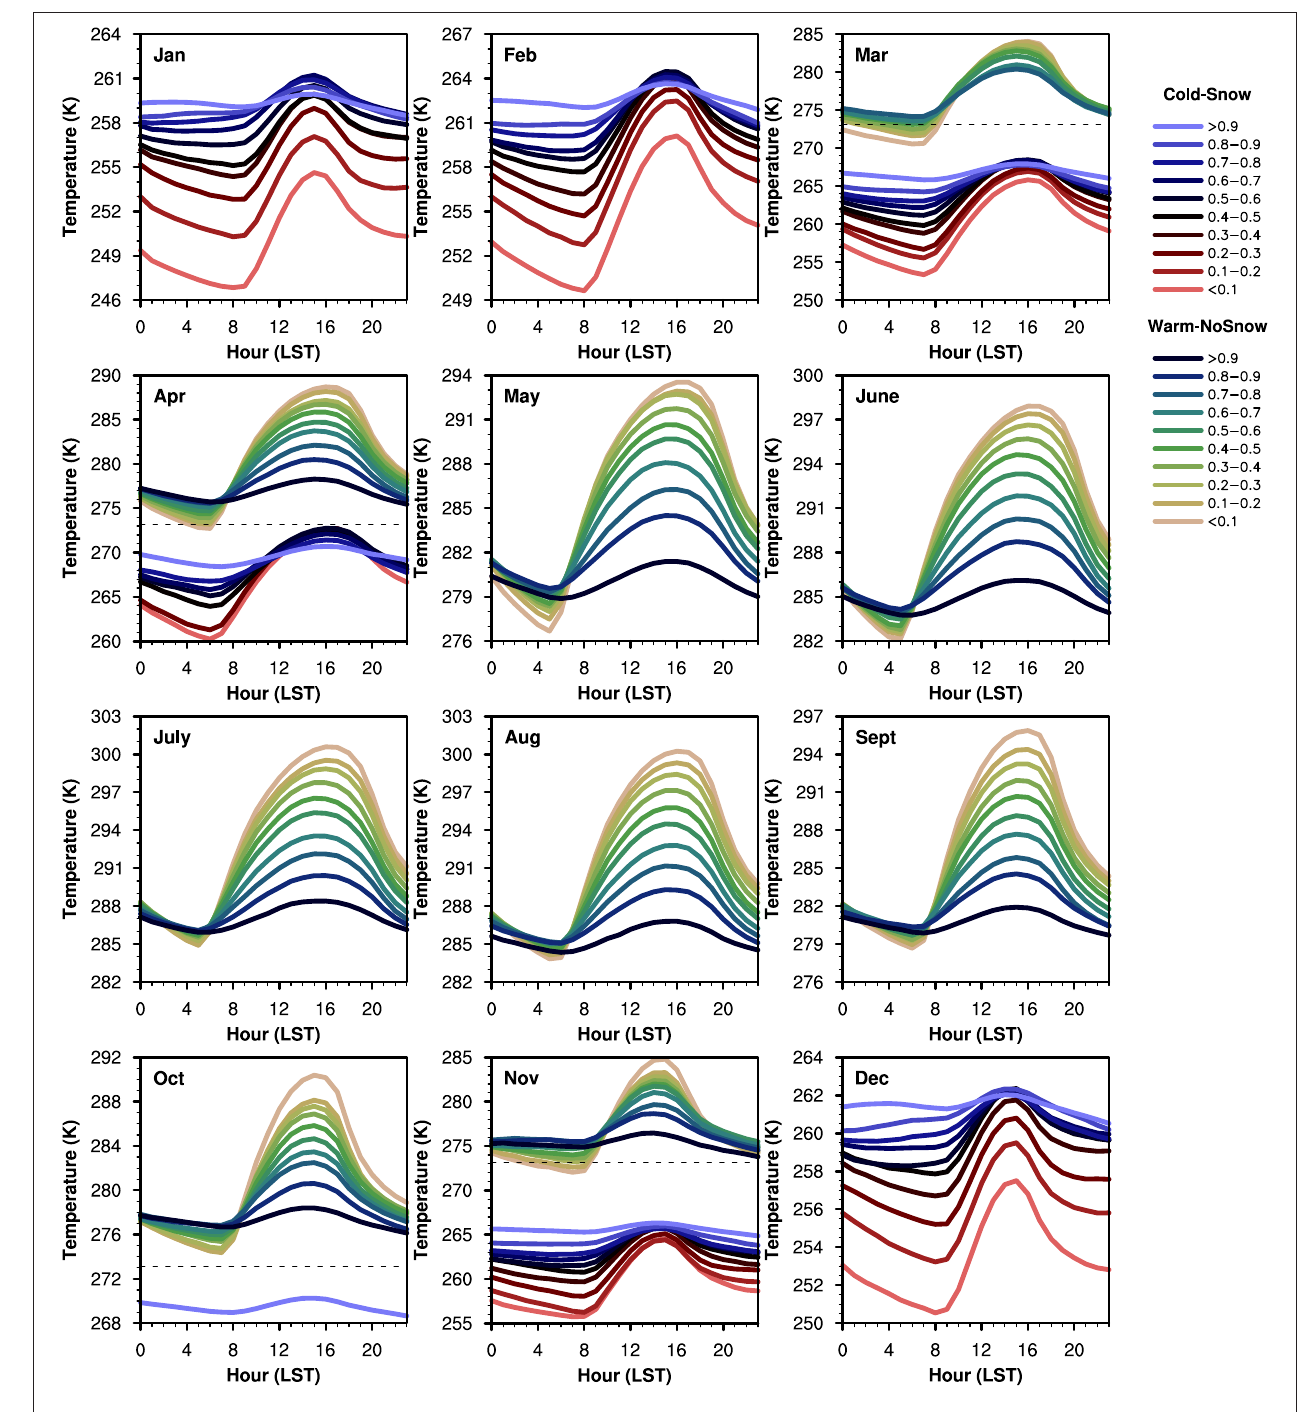
FIGURE 13 | Monthly diurnal cycles for cold-snow and warm-no-snow classes, stratified by OPAQ m .